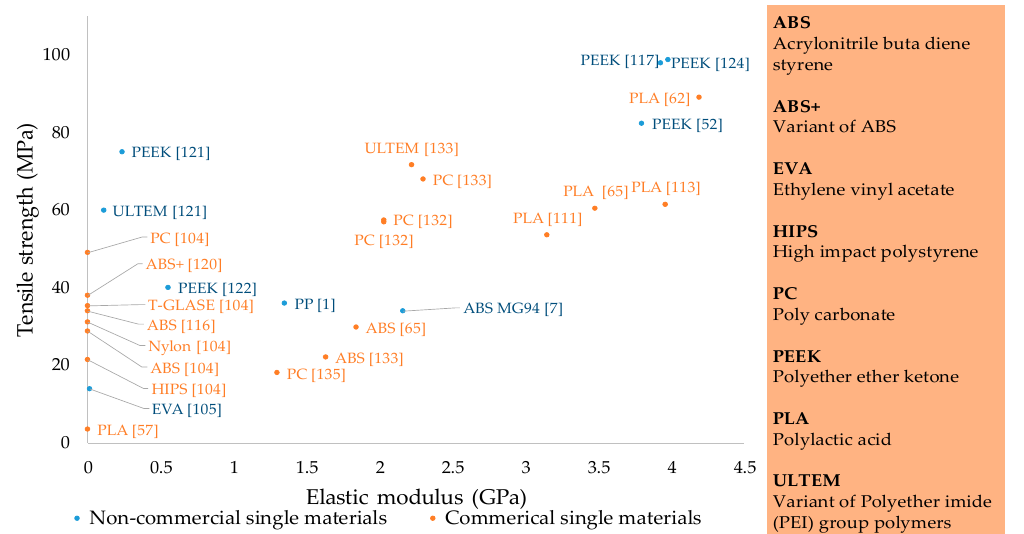
Figure 3. Tensile strength and elastic modulus of single materials of fused deposition modeling.